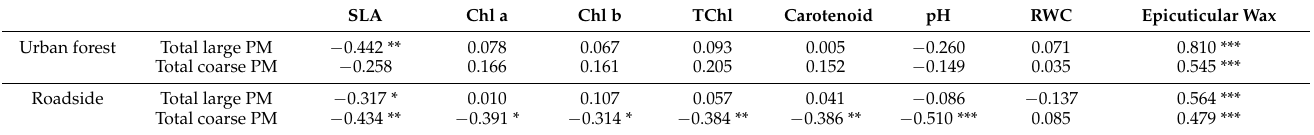
Table 4. Pearson correlation analysis of PM accumulation and leaf traits of 10 plant